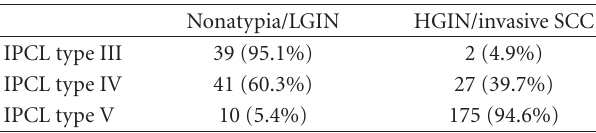
Table 3: Relation between IPCL pattern classification and pathol- ogy, P < 0 . 0001.